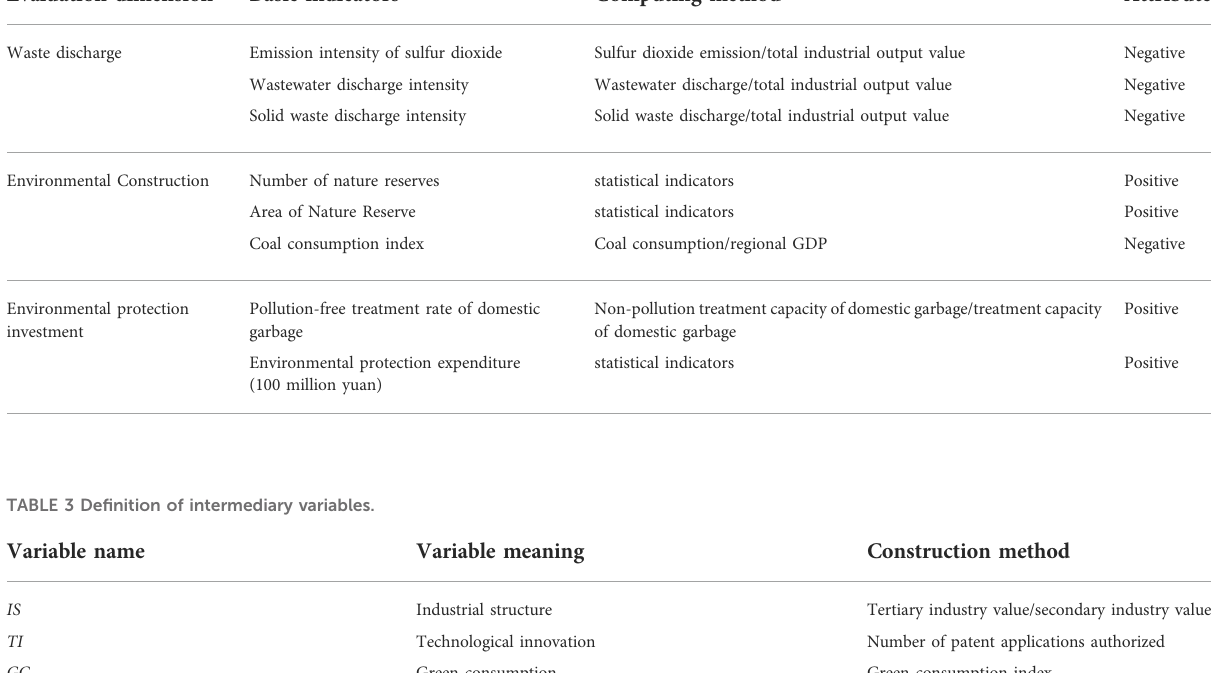
TABLE 2 Environmental assessment system.